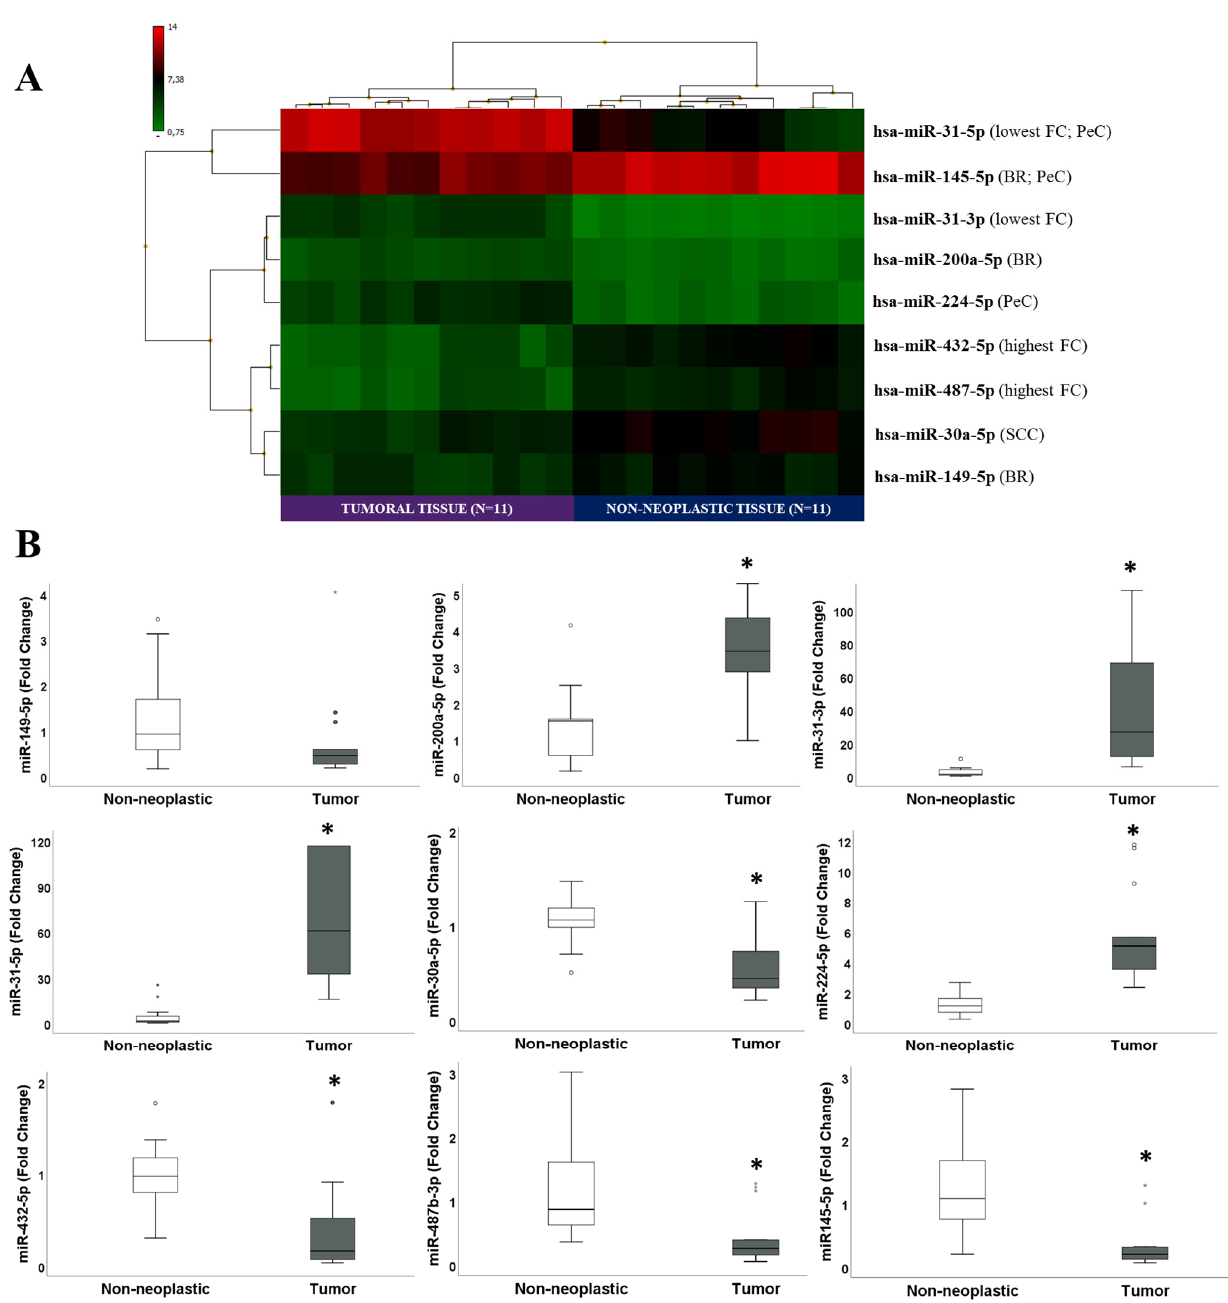
Figure 1. Differentially expressed miRNAs (DEmiRs) identified in the comparison between tumoral tissues (TT) and non-neoplastic tissues (NNT) by microarray analysis ( n = 11) and chosen for validation in the independent cohort of penile cancer (PeC) patients ( n = 13). ( A ) Hierarchical clustering analysis shows that the nine DEmiRs chosen for validation were able to cluster samples according to group. The reason for the selection of each DEmiR is indicated in parenthesis (FC: fold change; BR: Biological Relevance; SCC and PeC: previously described at Squamous Cell Carcinoma and penile cancer, respectively); ( B ) The box-plots represent the comparison of the expression levels of the nine selected DEmiRs in the TT ( n = 13) relative to NNT ( n = 13) in the independent validation set of samples; only miR-149-5p was not validated; * p < 0.05.